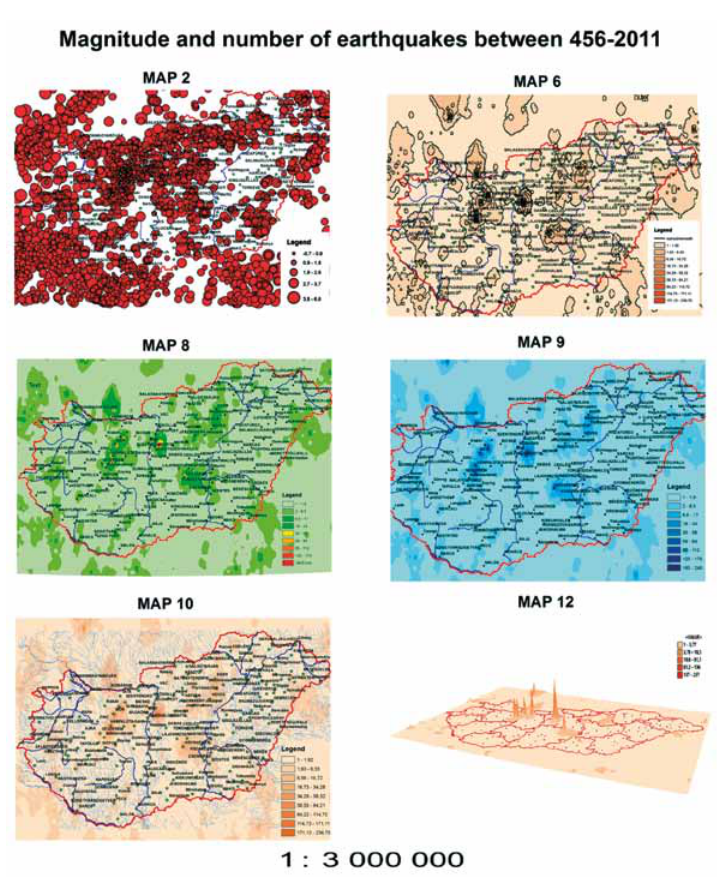
Fig. 2. Test maps showing magnitude or the number of